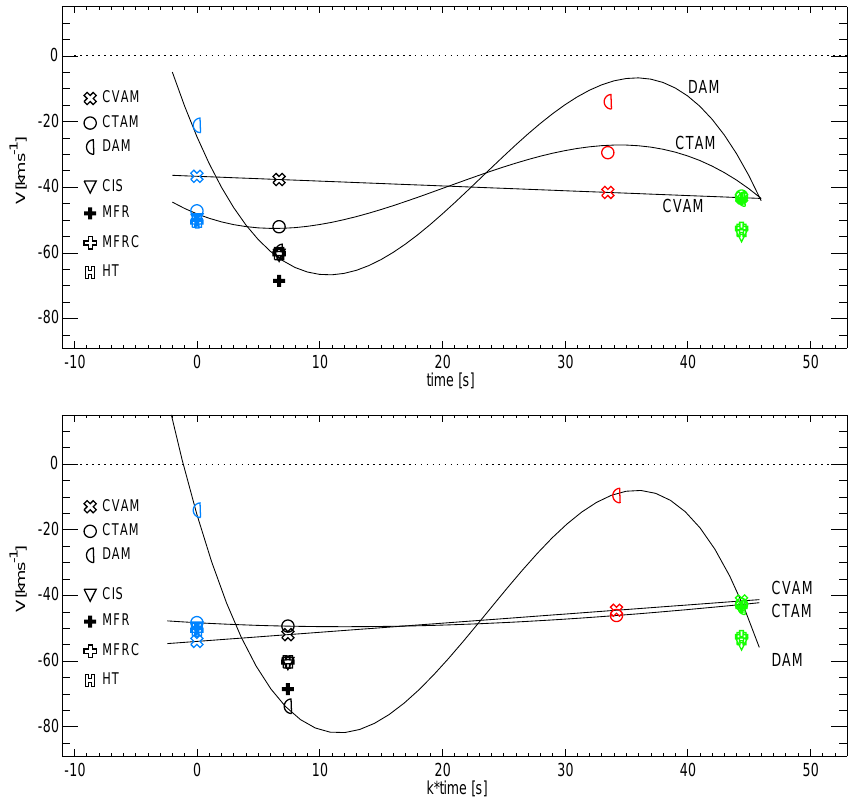
Fig. 4. Velocity curves from modified multi-spacecraft methods: CVAM, CTAM, and DAM. Upper panel; FGM based results, lower panels; EFW based results. Symbols and other notation as in Fig.